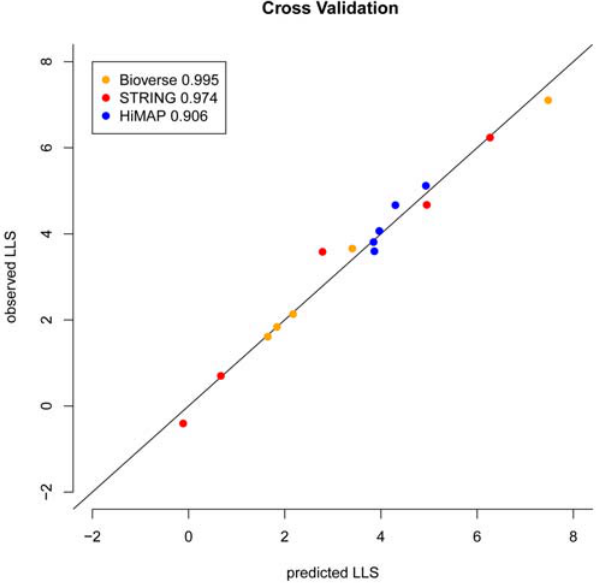
Figure 3. Cross validation. Three-fold cross validation was applied for each of the three databases independently. Training of the LLS prediction was done based on two-thirds of the reference data. The x- axis represents the predicted LLS from the training parameters while the y-coordinate represents the actual enrichment with true positives in the test set. The data were binned in five bins and the dots show the respective LLS for each bin. The color indicates the source database. For all three datasets predicted and observed results are very close to the ideal case (solid line). The correlation coefficients between predicted and true LLS are reported in the figure legend.